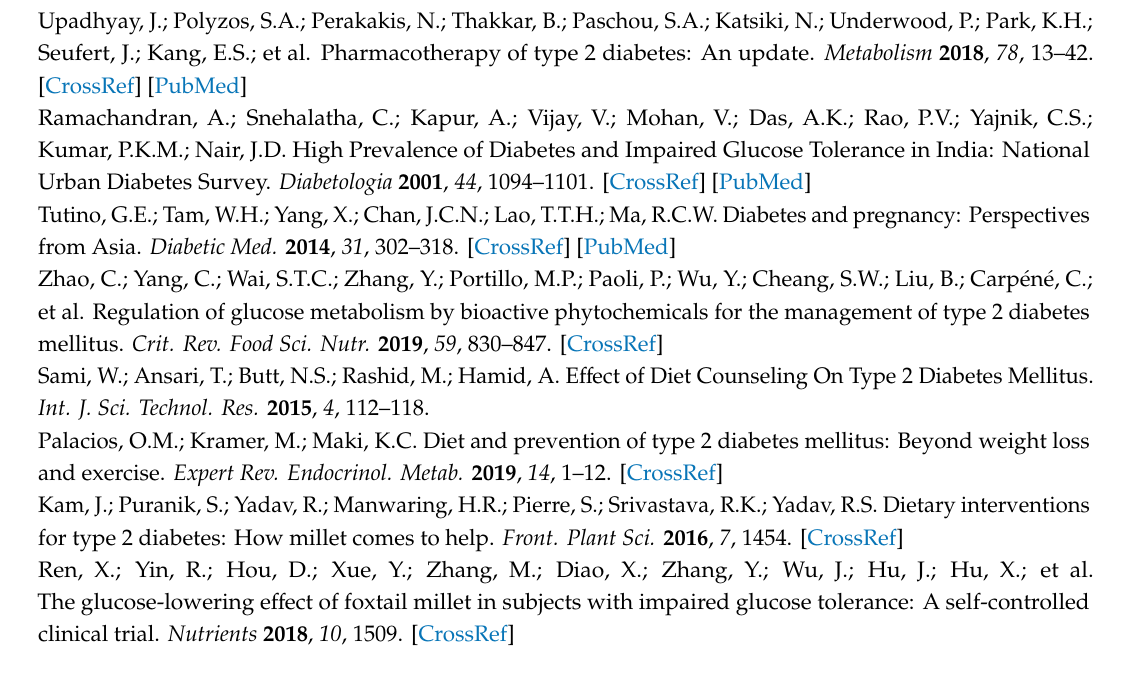
Figure S1: Alpha diversity analysis of samples by rarefaction analysis (A) and Shannon index (B). Figure S2: E ff ect of PCFM administration on (A) body weight (B) body weight gain in diabetic mice. Figure S3. After 5 weeks’ treatment, e ff ect of PCFM administration on HOMA-IR index in diabetic mice. Figure S4. After 5 weeks’ treatment, e ff ects of PCFM administration on gut microbiota composition in diabetic mice. Figure S5. Predicted metabolic pathways of the fecal microbiome after oral PCFM. Figure S6. Bubble chart showing the key altered metabolic pathways due to diabetes. Figure S7. Heatmap of di ff erential metabolites in all experimental groups. Table S1. List of serum metabolites changed among the NC, MC and PCFM groups. Table S2. Summary of the KEGG pathways influenced by diabetes in